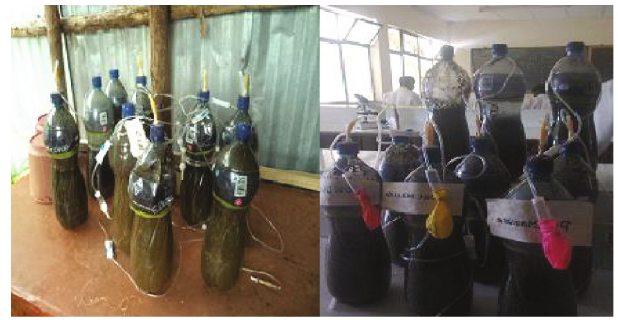
Table 2: Average of temperatures in animal biogas production digester.